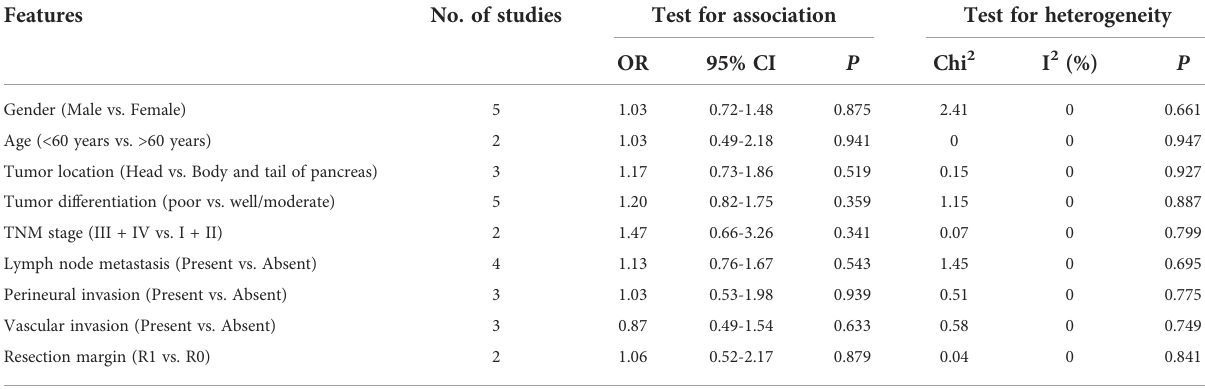
TABLE 2 The relationship between GLUT1 and clinicopathologic characteristics. Features No. of studies Test for